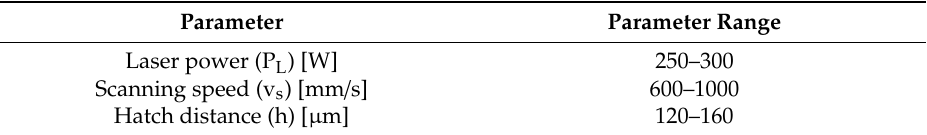
Table 2. Investigated processing parameters for the fabrication of 16MnCr5 specimens using PBF-LB / M. Parameter